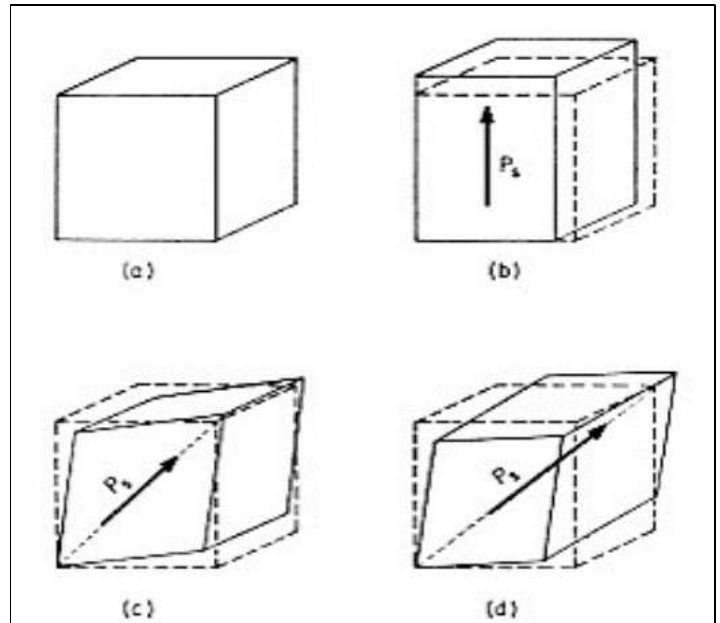
Figure 2: unit cell of four phases of Barium Titanate, (a) cubic phase above curie point (120) ◦ C, (b) tetragonal phase occurs between (5<T<120) ◦ C, (c) orthorhombic phase stable at (-90 <T< -5) ◦ C, (d) Rhombohedral phase this phase-stable below T=-90 ◦ C [6].